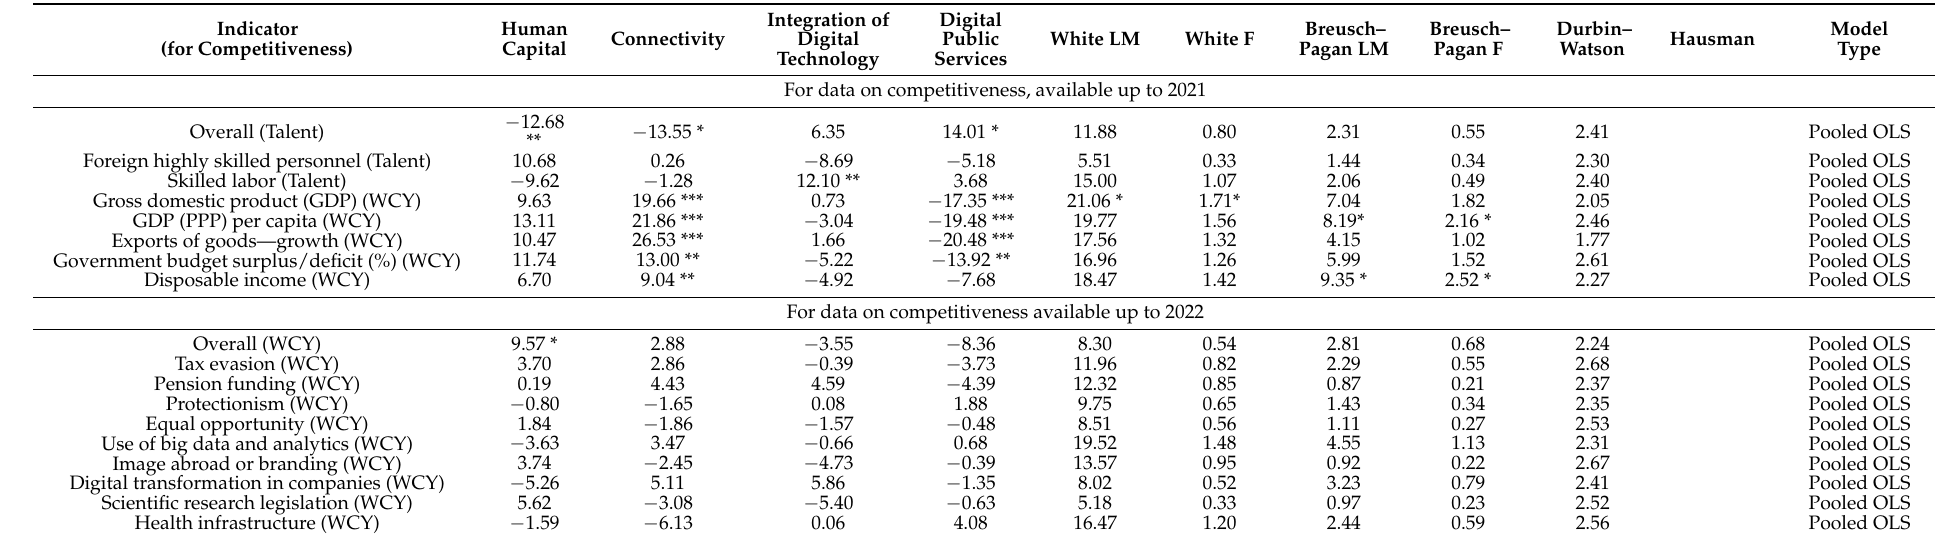
Table 6. Results for the scenario when DESI components are considered for Western European